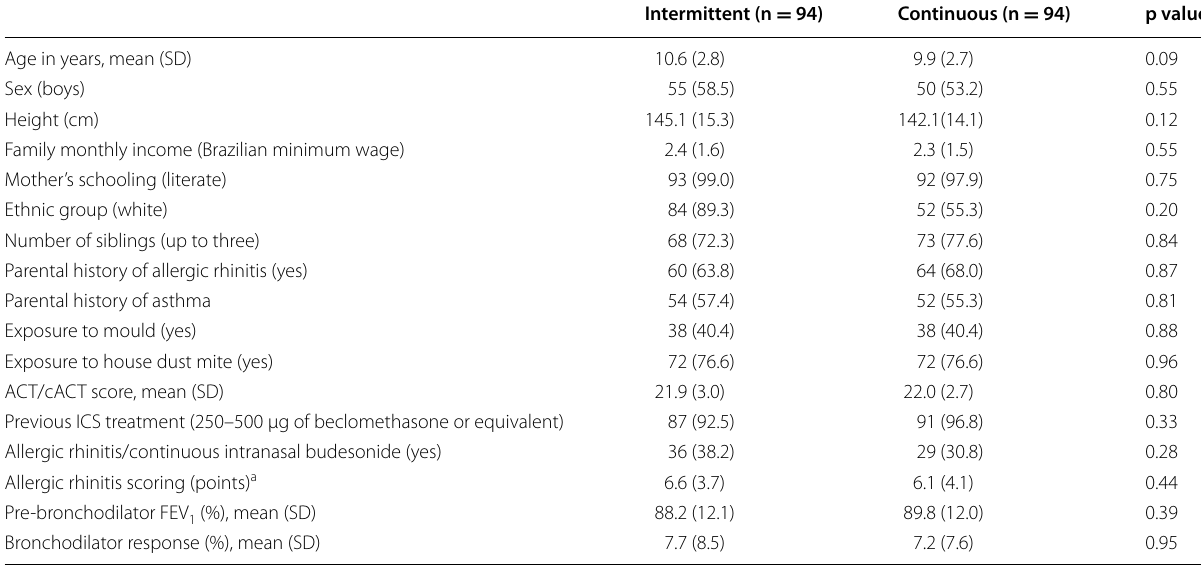
Data are proportions (%) or means (SD) unless stated otherwise; one Brazilian minimum wage corresponded approximately to US$ 250.00 during the study period